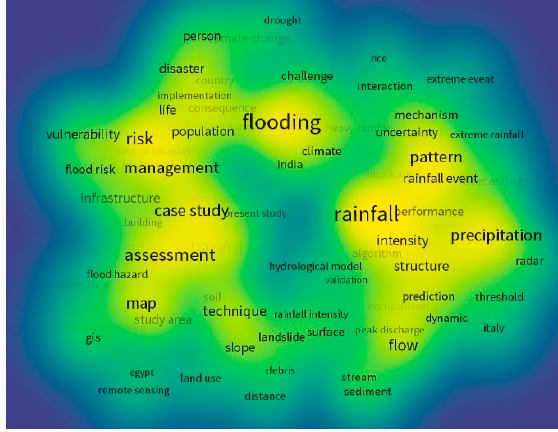
Figure 11. Keyword co-occurrence density view.